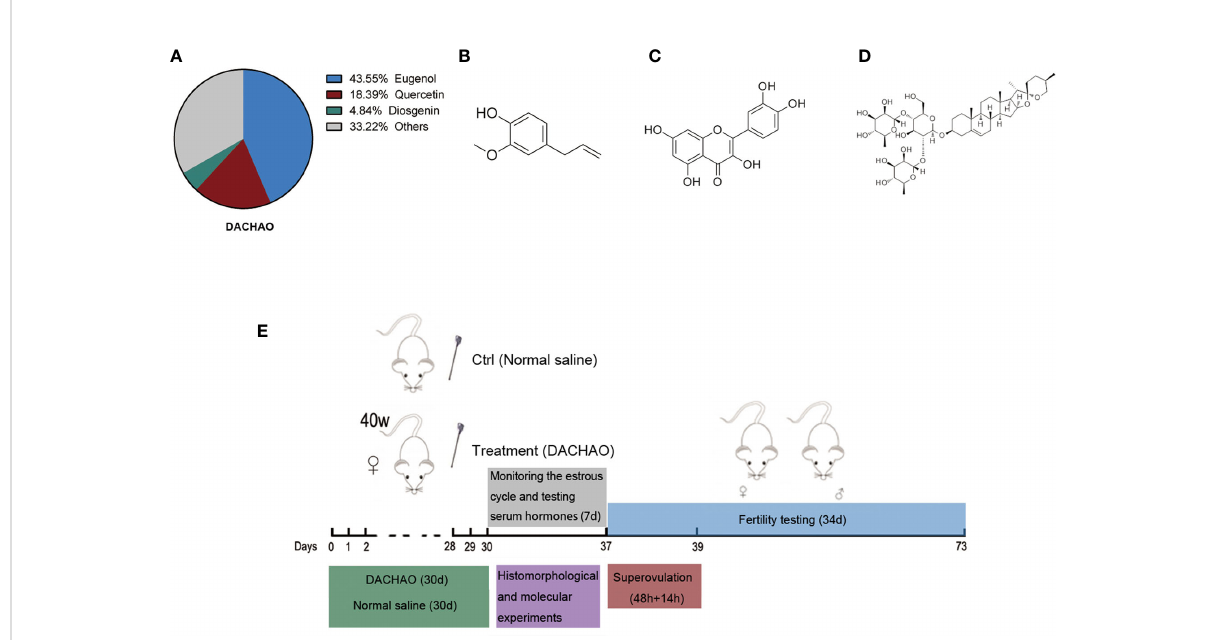
FIGURE 1 Establishment of a gavage model in aged female mice and DACHAO characterization. (A) Aging mice models were established in the experiment: female mice at 40 weeks of age were administrated with DACHAO (310 mg×kg- 1) daily for a month. In control group, mice were gavaged with the same volume of normal saline (green region). After gavage, the mice were tested for estrous cycle immediately. Blood samples were collected from mice during the diestrus randomly to detect serum hormone levels (gray region). The remaining mice were randomly divided into 3 parts. A random selection of 5 mice were co-caged mating for fertility testing (blue region). A random selection of 8 mice were euthanized and the ovaries of them were collected for histomorphological and molecular experiments (purple region). The remaining mice were superovulated and euthanized in batches when needed, then oocytes were collected for experiments (red region). (B) Via high performance liquid chromatography test and calculation, the proportion of each main component in DACHAO. (C – E) Chemical structures of eugenol, quercetin, and